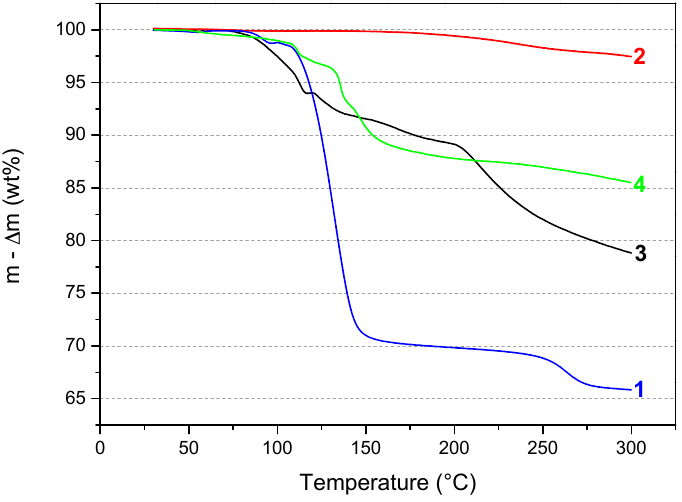
Figure 5. Superimposition of the TGA curves of 1 (N 2 H 4 BH 3 ; from ref. [5]), 2 (LiNH 2 ), 3 (LiN 2 H 3 BH 3 · x NH 3 ), and 4 (LiN 2 H 3 BH 3 ; from ref. [8]).